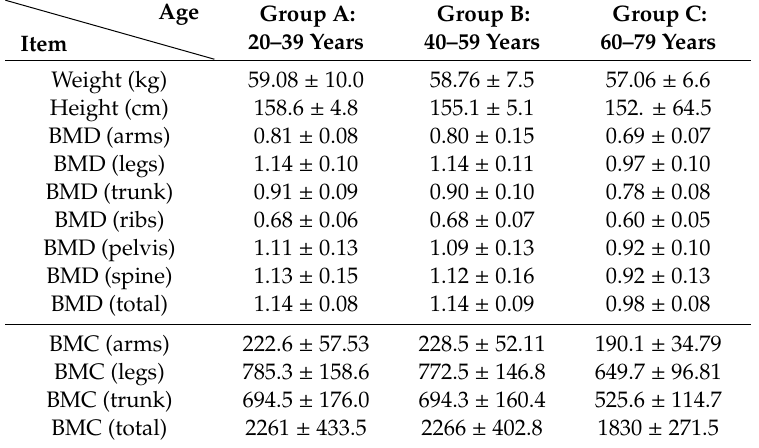
Table 3. The mean values weight, height, BMD, and BMC in various body segments of female participants.